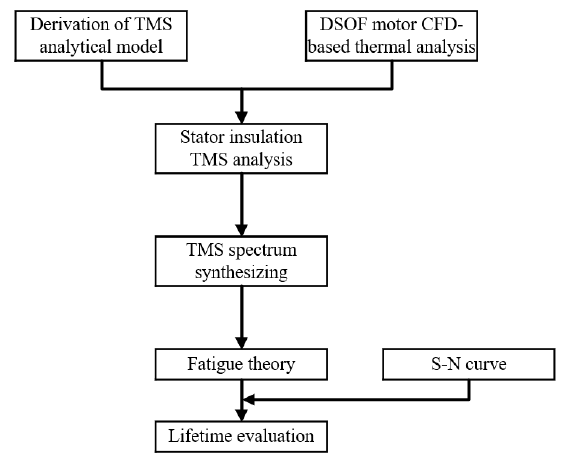
Figure 1. Flow chart of DSOF motor fatigue lifetime